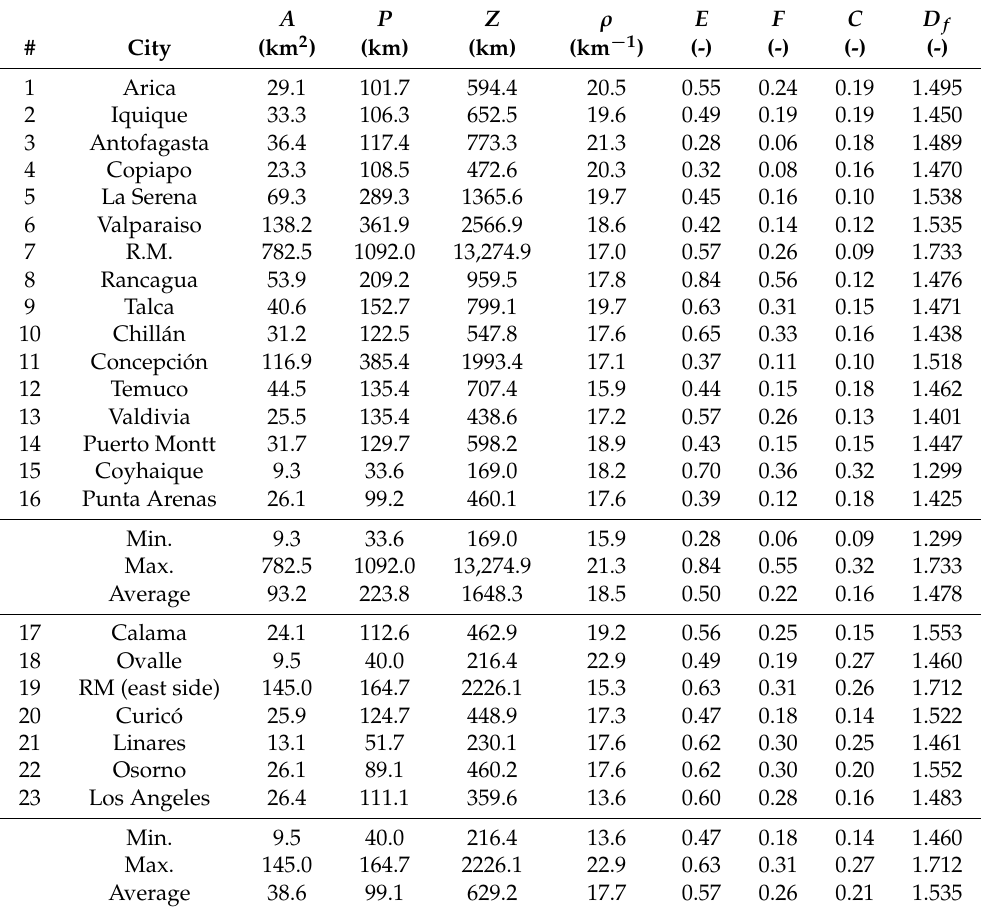
Table 2. Morphometric indices of Chilean cities ordered from north to